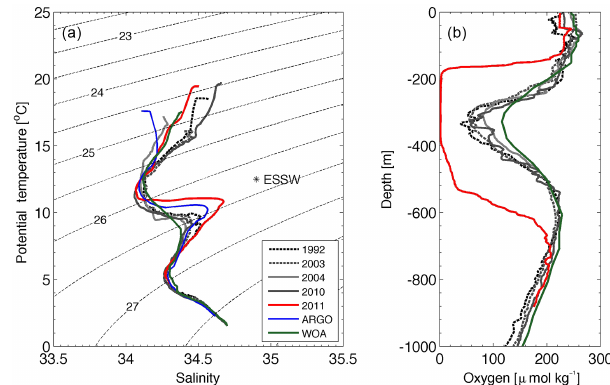
Figure 2. (a) T − S diagram from various sampling programs in the study area; (b) dissolved oxygen profiles at Tara station 094- A (red line) and stations in its vicinity from cruises conducted on 1992 (black dashed line), 2003 (gray dashed line), 2010 (thick gray line) and 2004 (thin gray line); from Argo buoys (blue line, without oxygen), and the WOA 2013 climatology (green line). More details on data sources are provided in Table